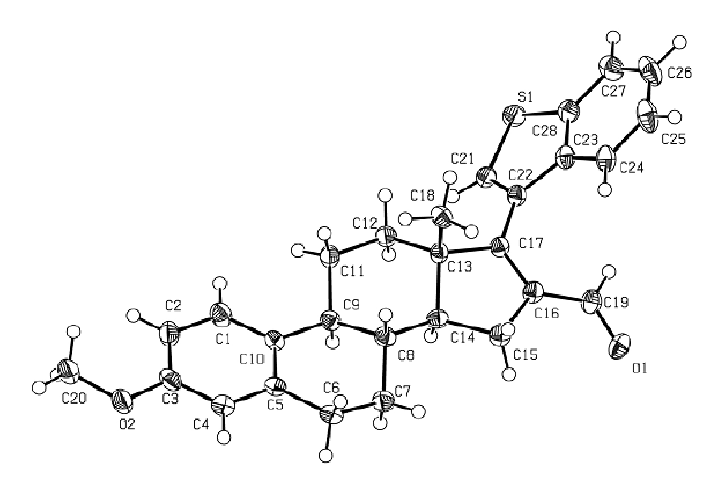
Fig. 2 A view of 5d with the atom-numbering scheme. Displacement ellipsoids are drawn at 50 % probability level and H atoms are shown as small spheres of arbitrary radii.